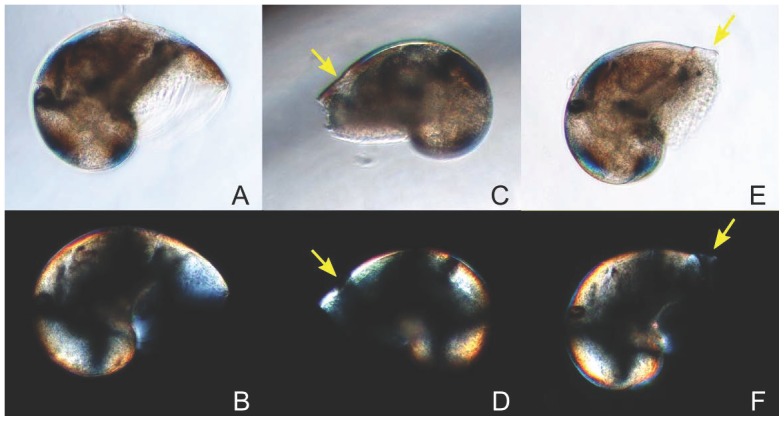
Shell abnormalities under normal (A, C, and E) and polarized (B, D, and F) light.A-B are pictures of a normal larva presenting the characteristic black cross of birefringence. C-D and E-F show examples of abnormalities observed among the samples, with arrows indicating less calcified zones.